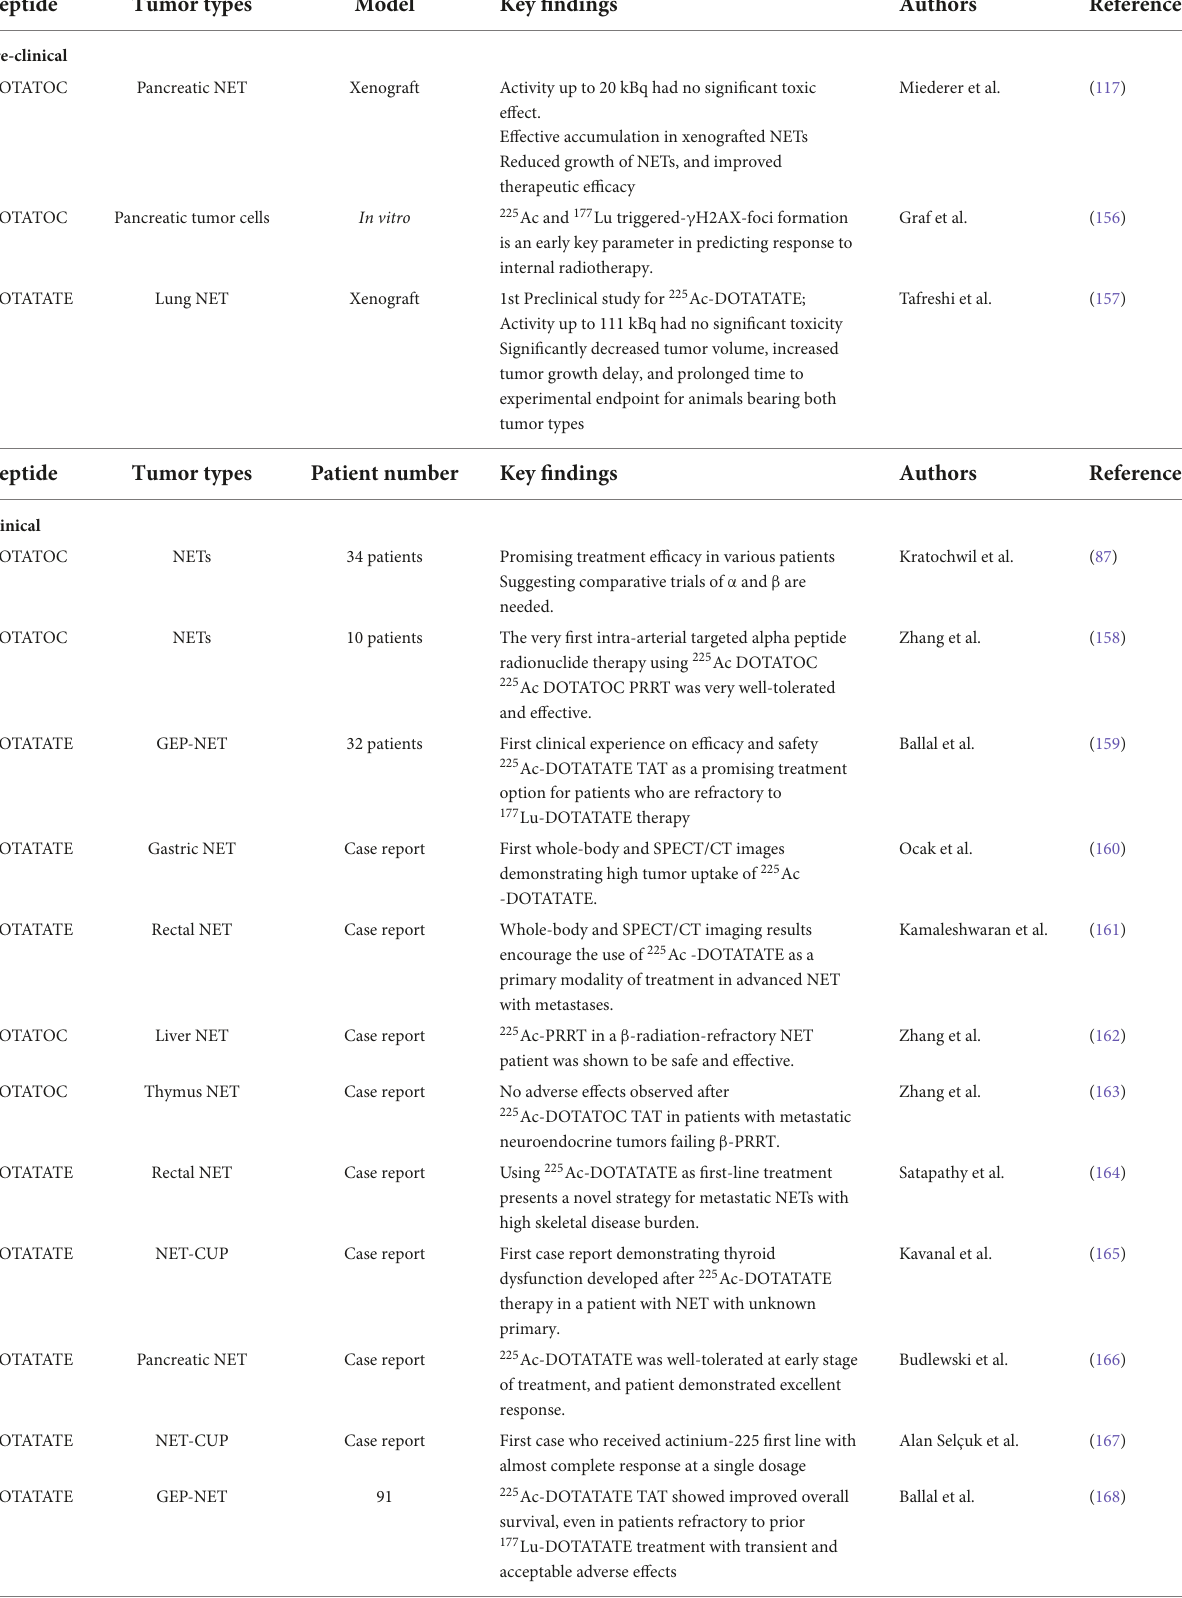
TABLE 3 Actinium-225-peptide receptor radionuclide therapy in NET